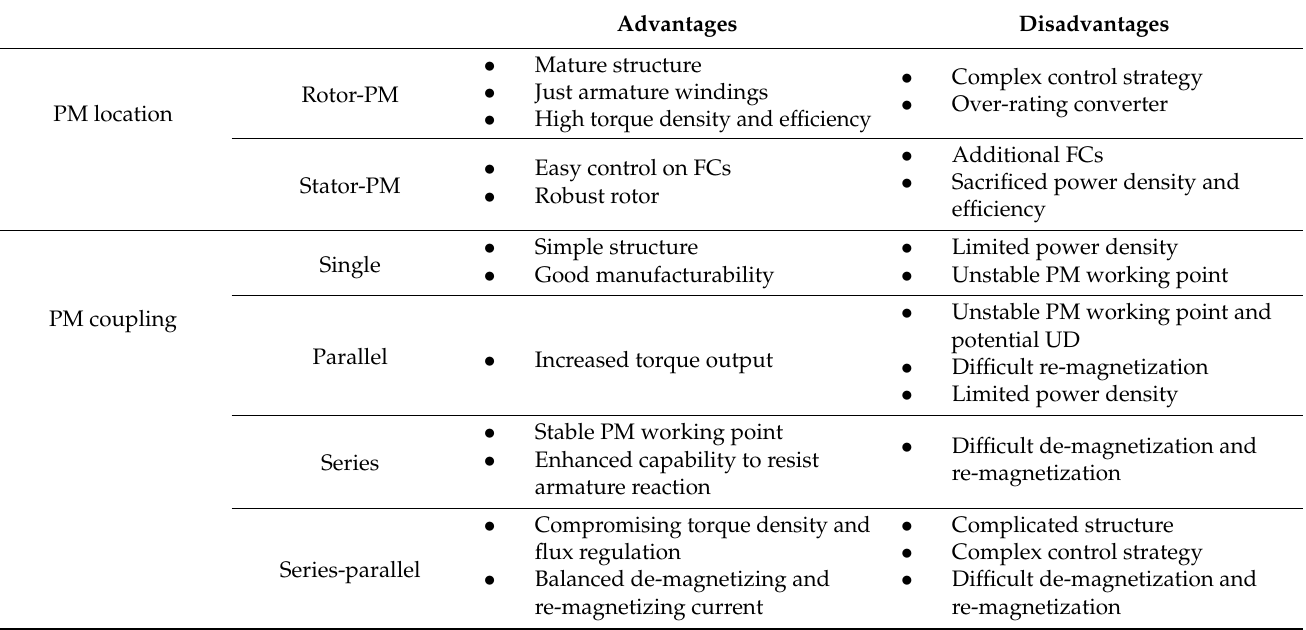
Table 2. Advantages and disadvantages of various VFM